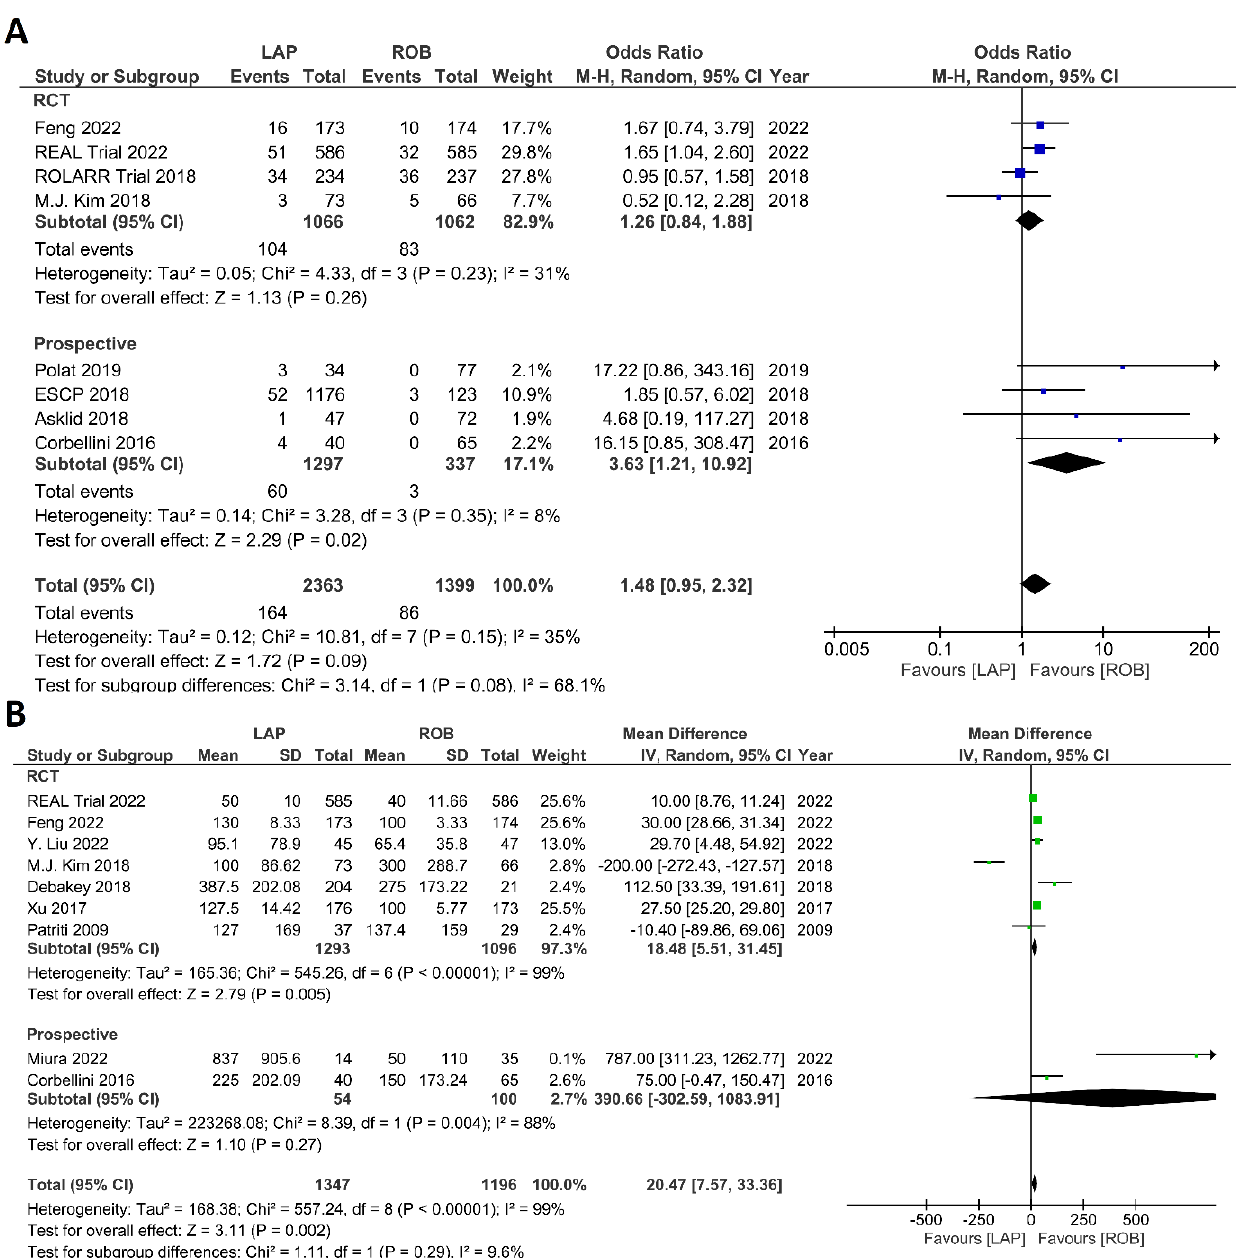
between robotic and open rectal resection (blue boxes representing odd ratios, green boxes repre- senting mean differences, arrows representing 95% confidence intervals, and diamonds representing point estimates of pooled odd ratios or mean differences).